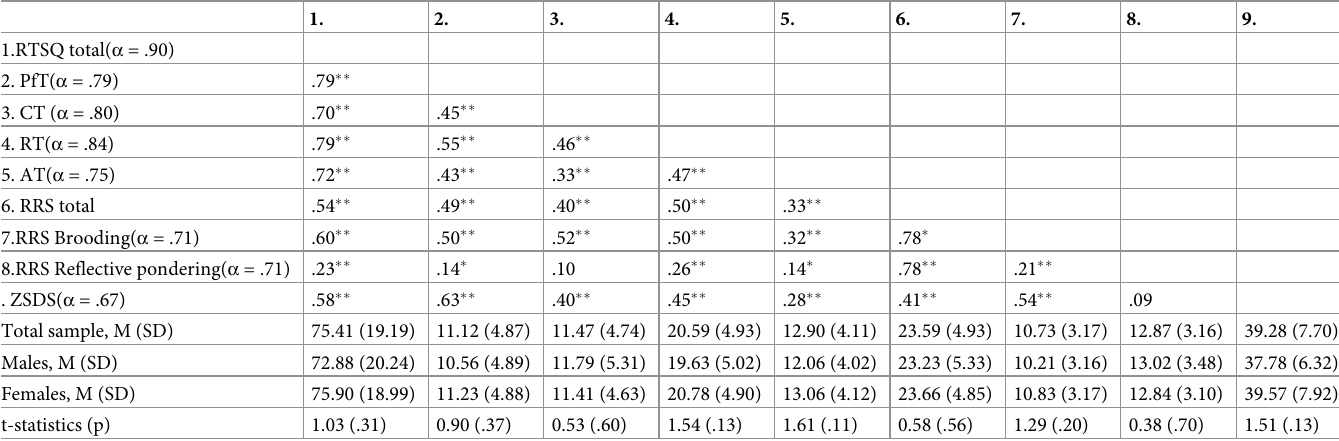
Table 8. Pearson correlations between measures along with the means, standard deviations and Cronbach’s alphas (Study 2). 1.